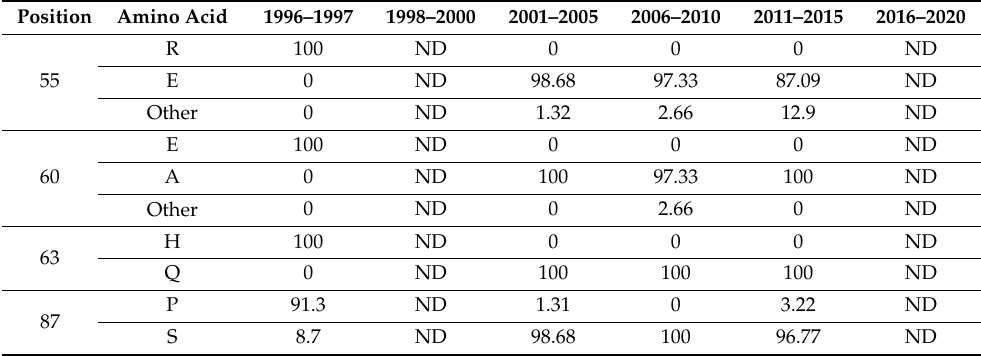
Table 4. Amino acid changes in NS1 proteins from H5N1 IAV isolated in